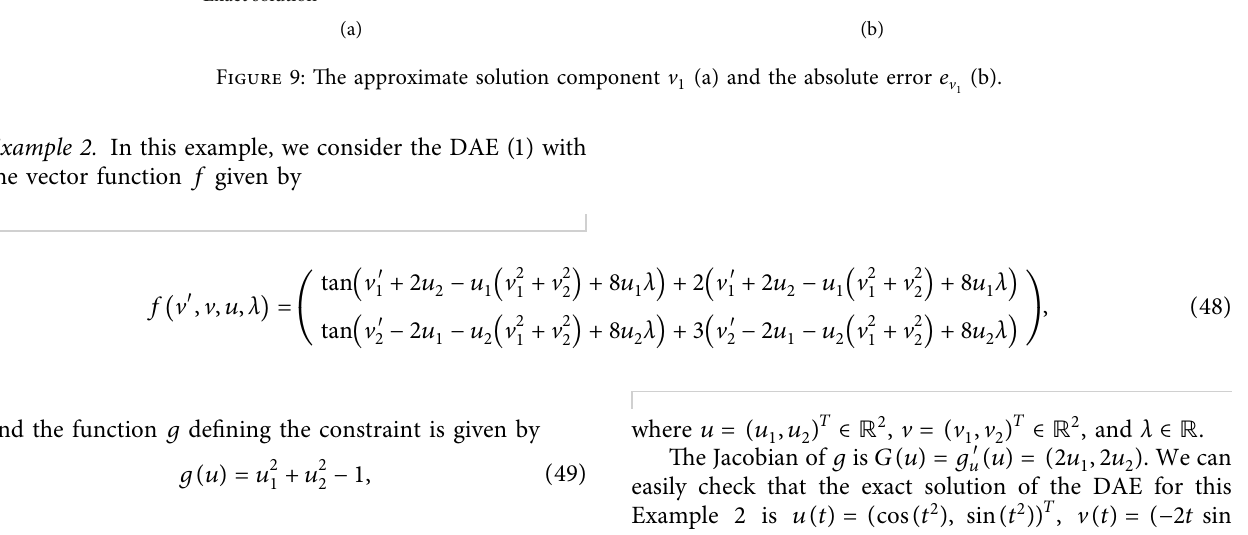
(a) and the absolute error e v 1